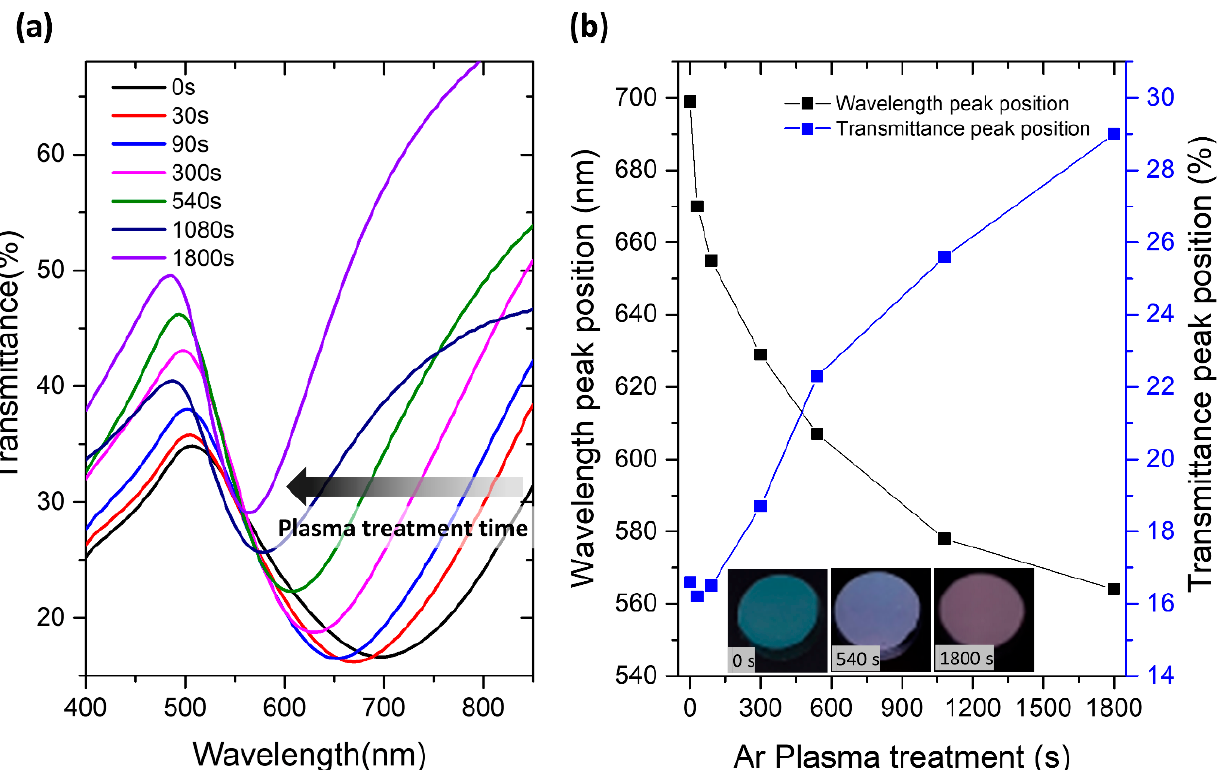
Figure 5. Transmittance spectra ( a ) of the Au:CuO thin films after different etching times with Ar plasma and wavelength and transmittance peak position ( b ) of the Au:CuO thin films as a function of Ar plasma treatment time, with inset of pictures of the Au:CuO thin films in transmittance after 0, 540, and 1800 s of Ar plasma.